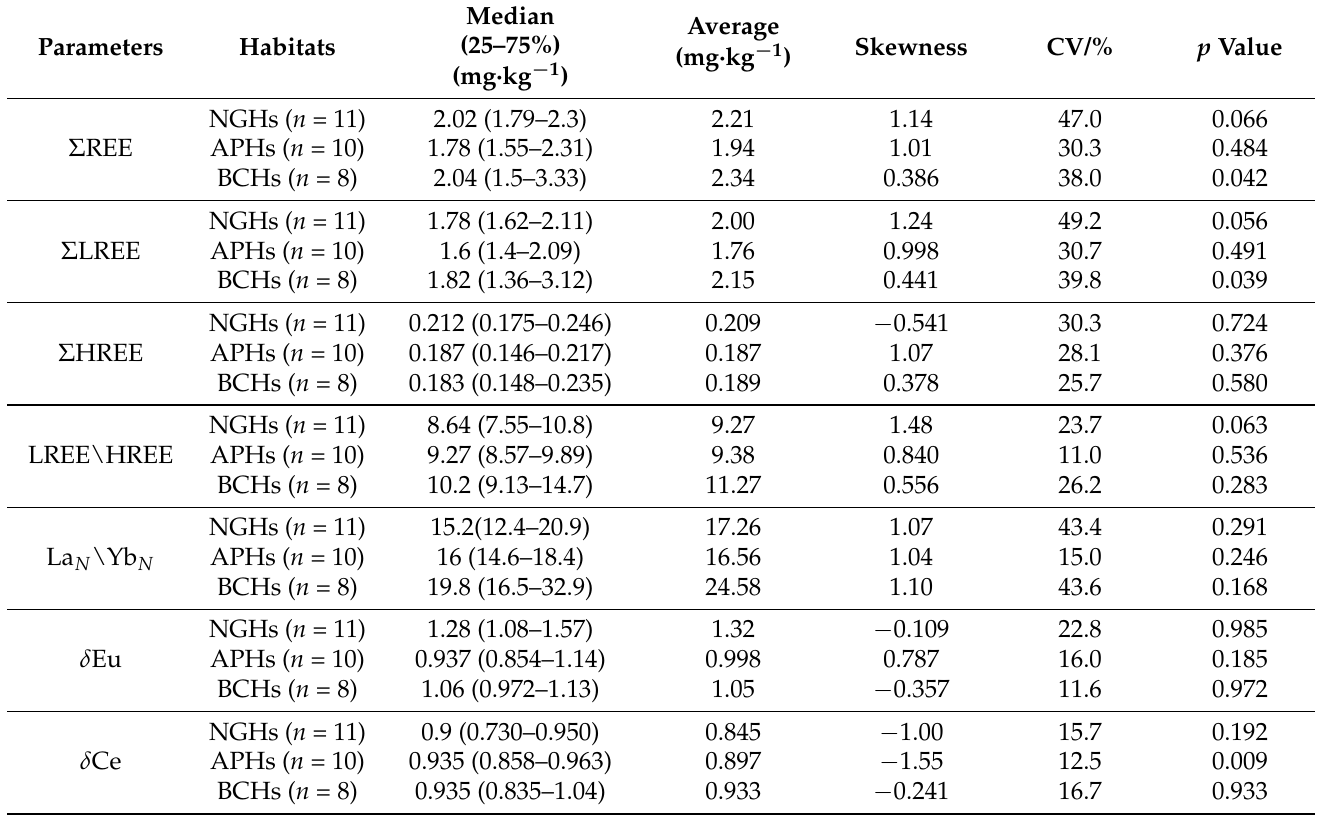
Table 3. Parameters of the REE distribution characteristics of Scutellaria baicalensis in various habitats, Hebei